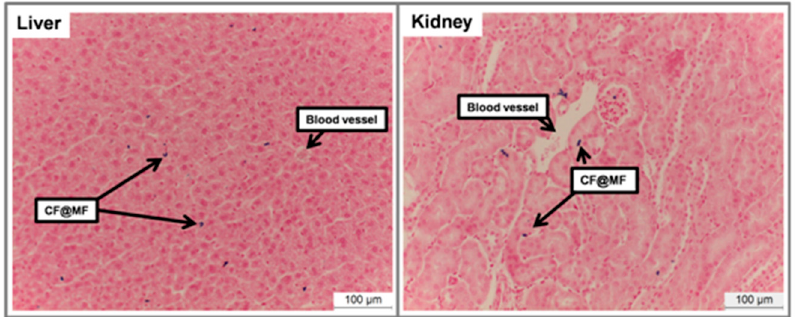
Figure 10. Prussian blue staining of representative histological sections at 24 h post-injection of PEGylated CF@MF NPs of liver (left) and kidney (right).